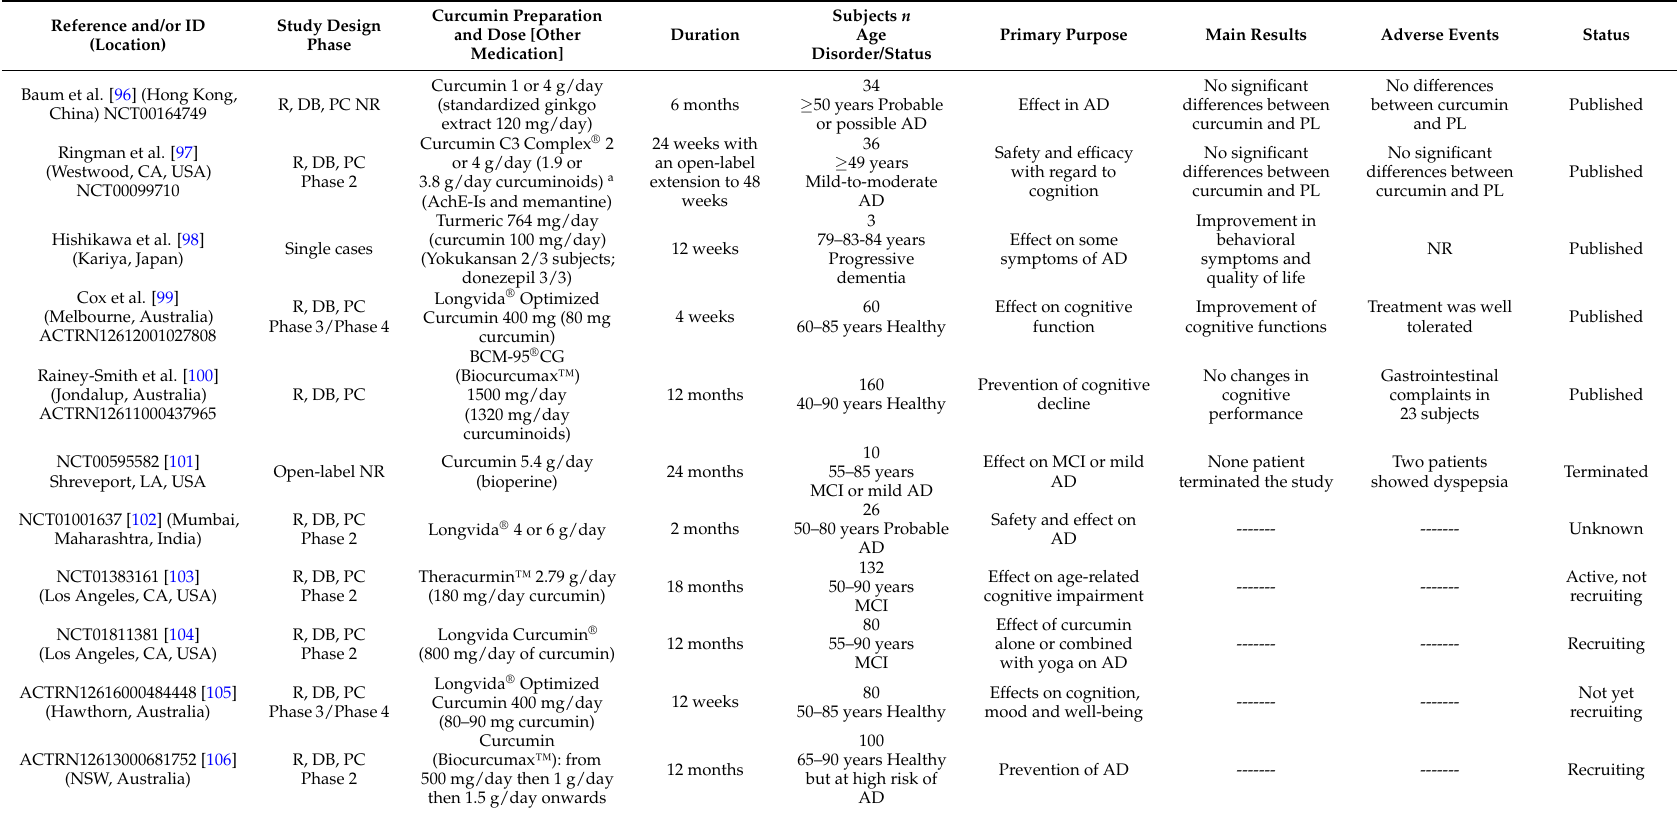
Table 1. Clinical trials on the effects of curcumin on cognitive